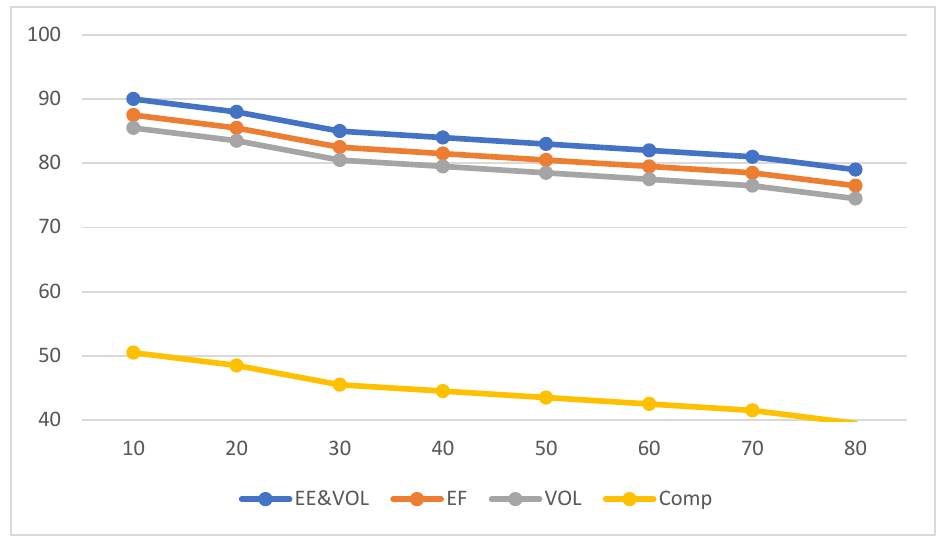
Figure 5. Accuracy versus the testing ratio of the models utilizing feature maps Map EE&VOL , Map EE , Map VOL , and the learning model without transfer learning using Map comp .